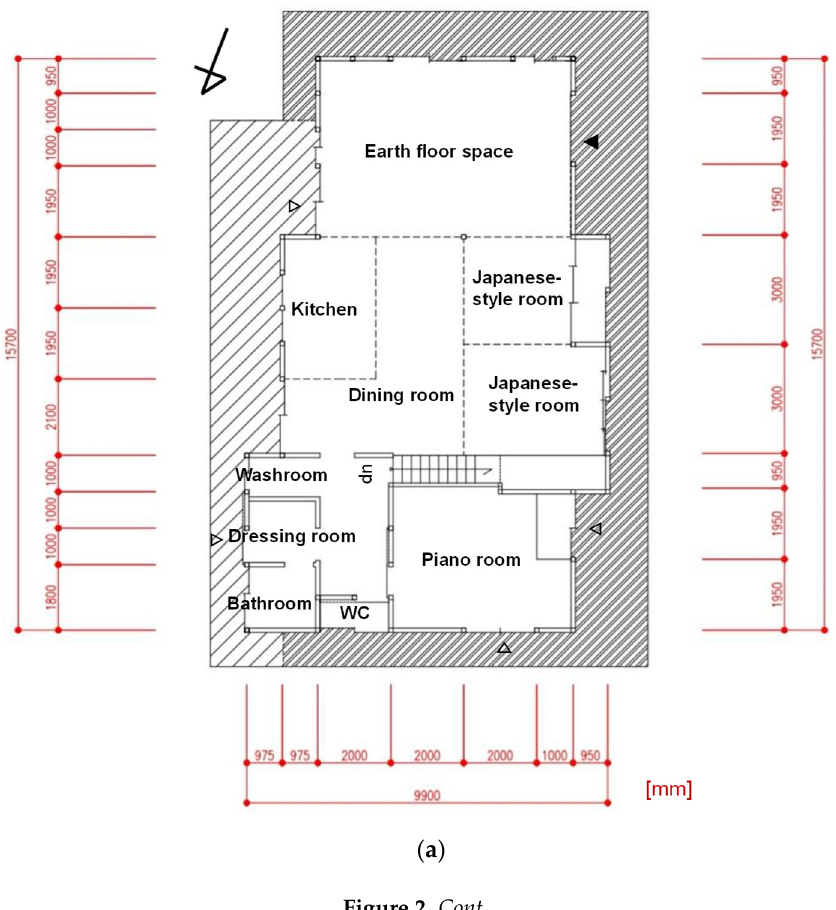
Figure 1. Photographs of ( a ) the subject house, ( b ) the earth floor space, ( c ) the Japanese-style room and dining room, and ( d ) underside of the thatched